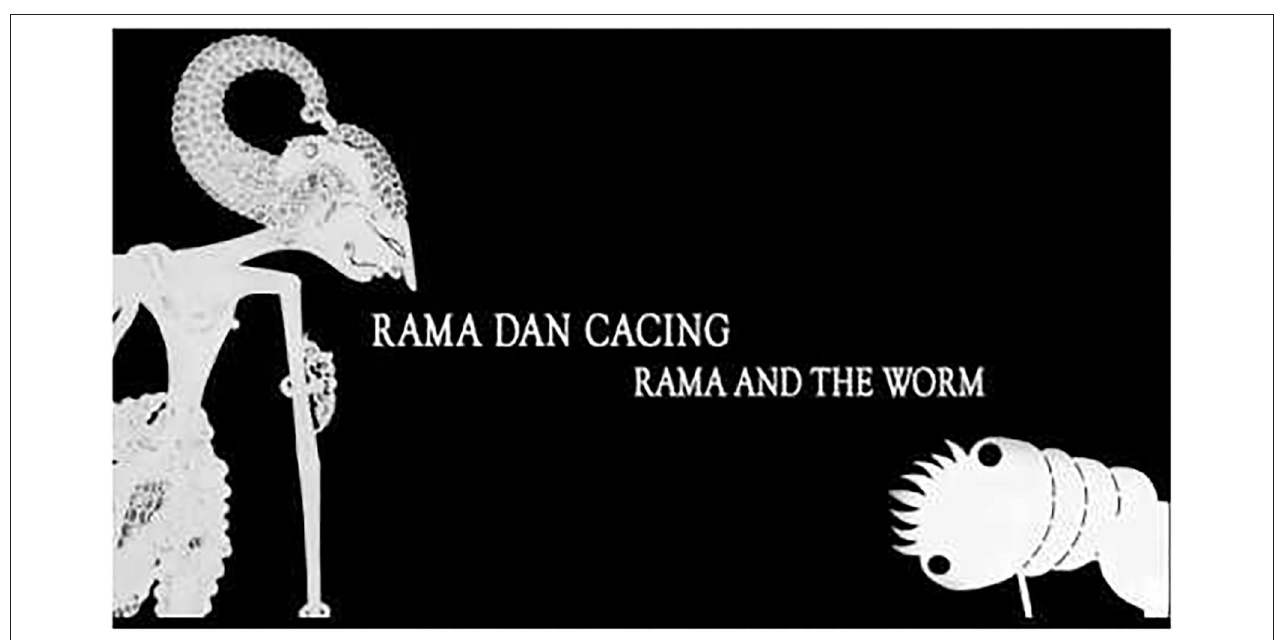
FIGURE 2 | Still from Rama and the Worm shadow puppet play taken from Youtube.com (48).